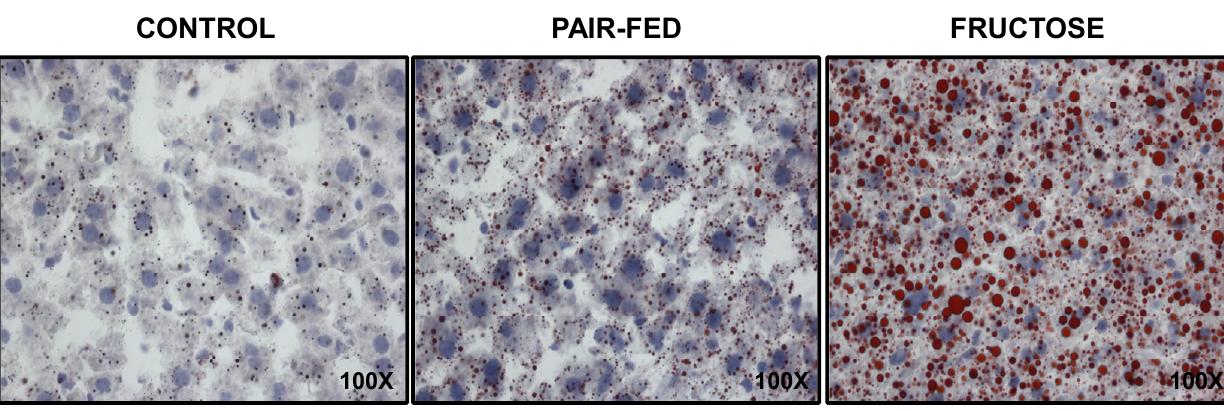
Figure 1. Oil Red O staining of frozen liver sections from control, pair-fed and fructose-fed mice. These sections are visualized at 100× magnification. The red staining corresponds to lipids and the blue stain corresponds to nuclei,